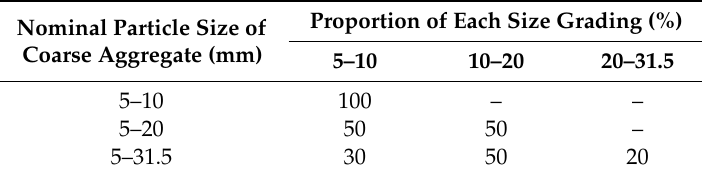
Table 5. Size grading of coarse